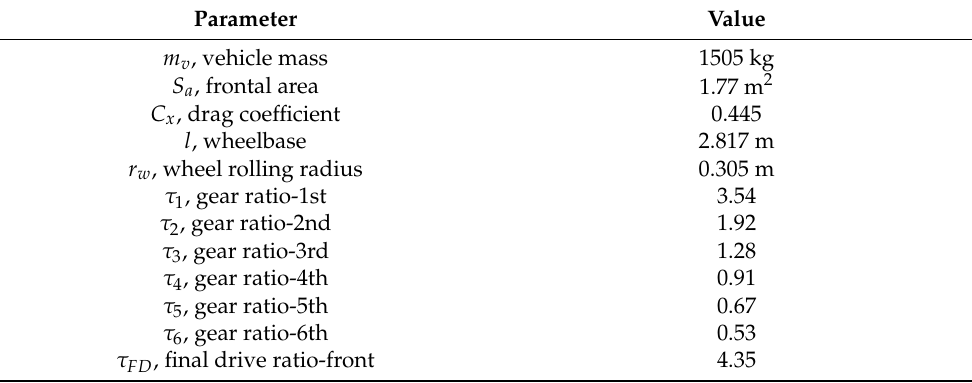
Table 1. Reference vehicle geometry and transmission main parameters.